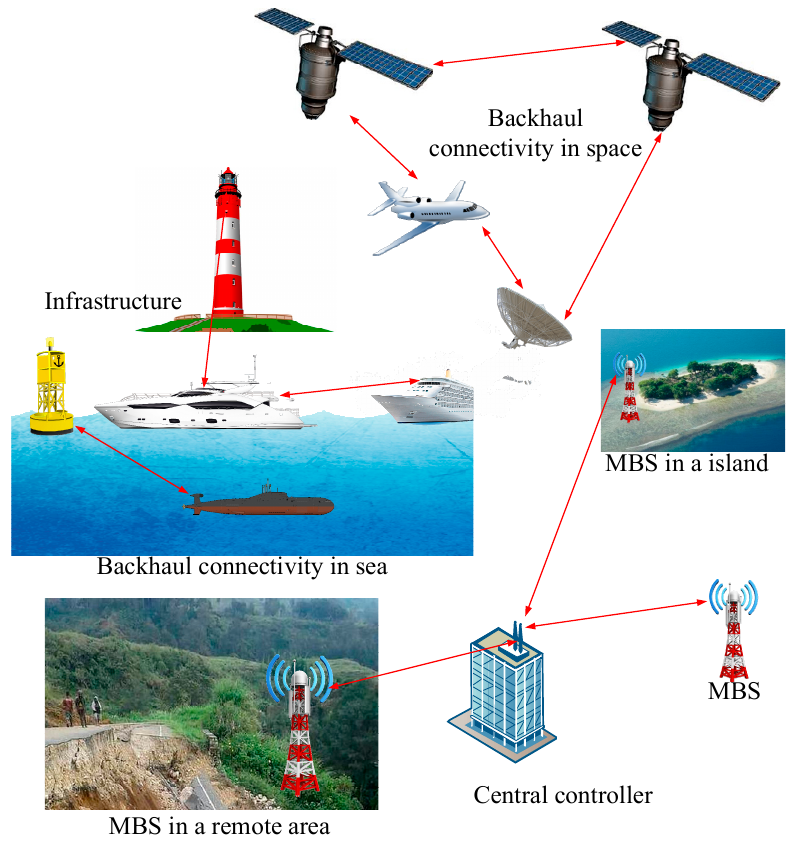
Figure 7. High-capacity backhaul connectivity for a remote hill, a remote island, and a remote city. Table 4. Comparison of the achieved data rates and latencies in the existing important backhaul technologies [2,9,44].